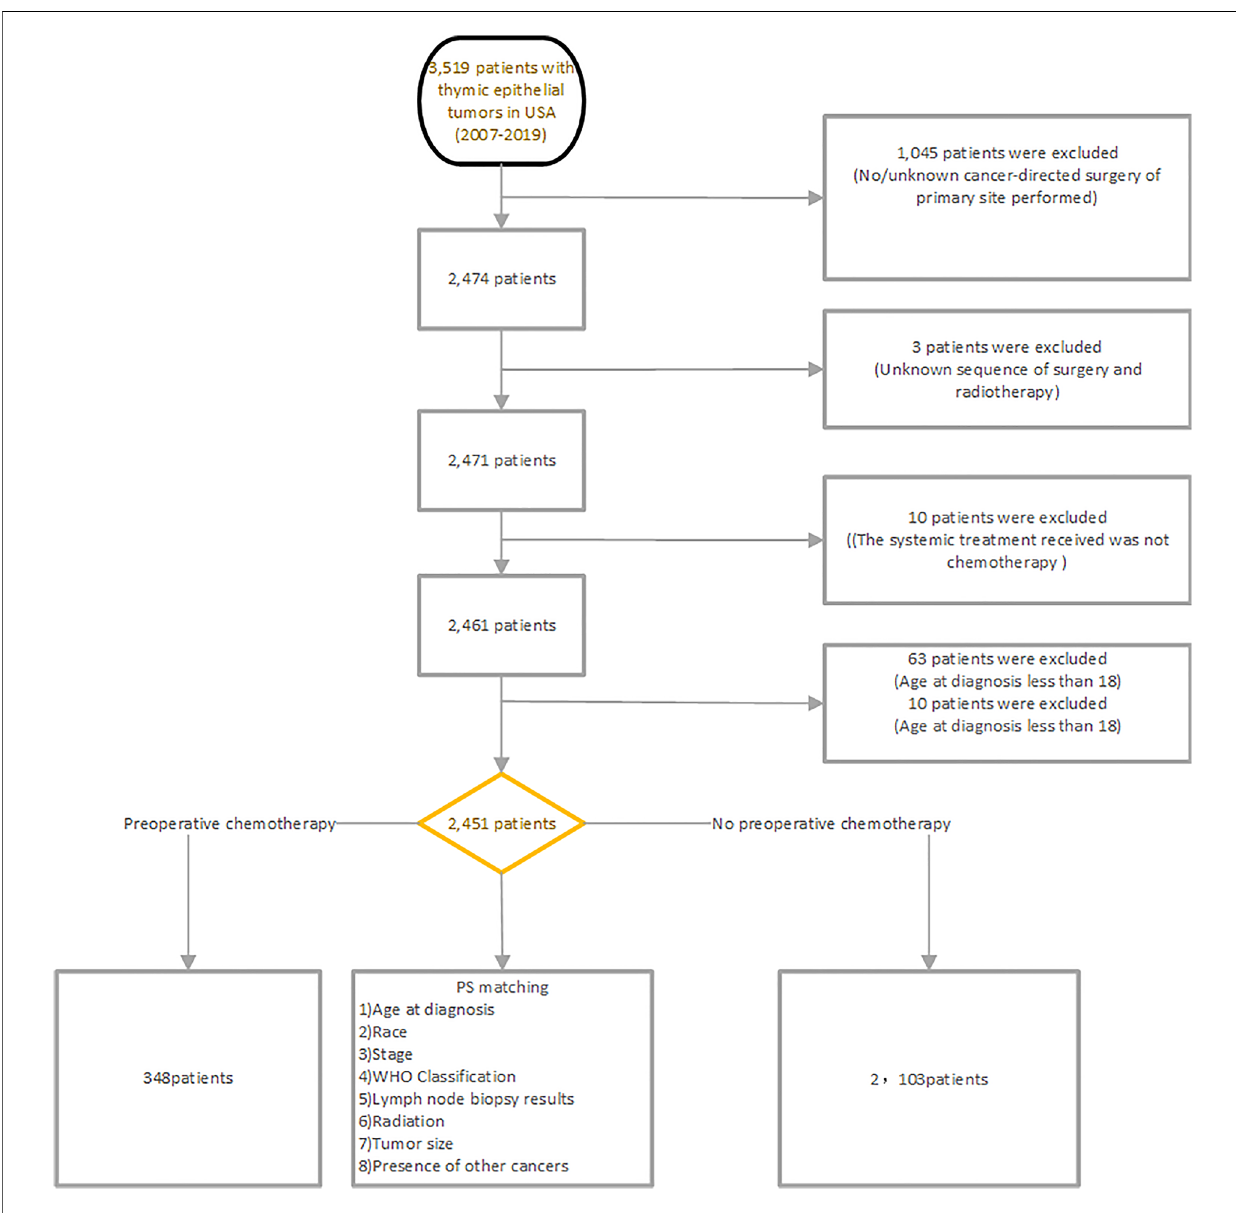
FIGURE 1 Demonstrates the fl owchart of case inclusion and exclusion in